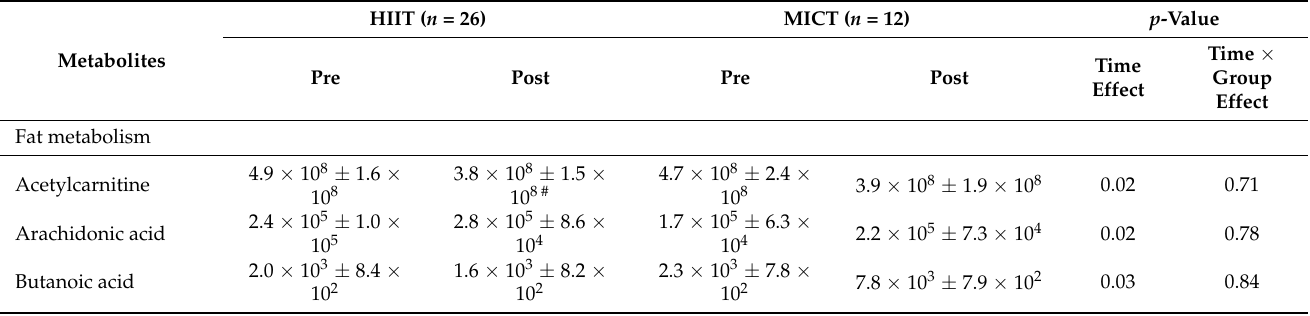
Table 3. Effect of a 12-week High-Intensity Interval Training (HIIT) and Moderate-Intensity Continu- ous Training (MICT) on metabolites of fat metabolism in obese older